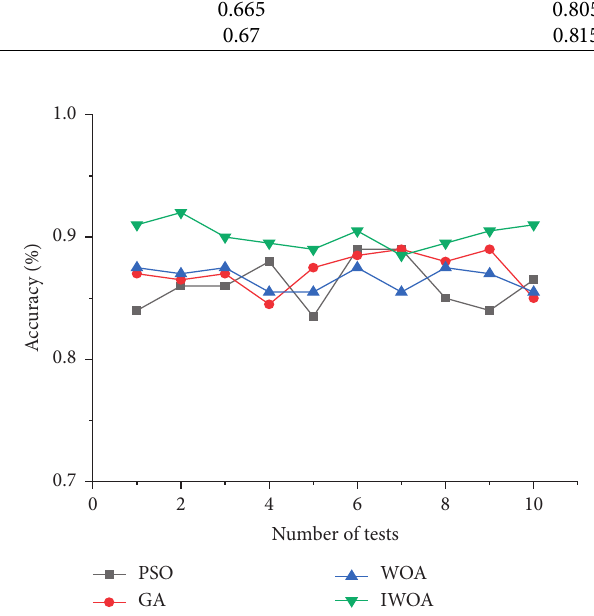
Figure 6: Diagnosis accuracy for 10 tests.